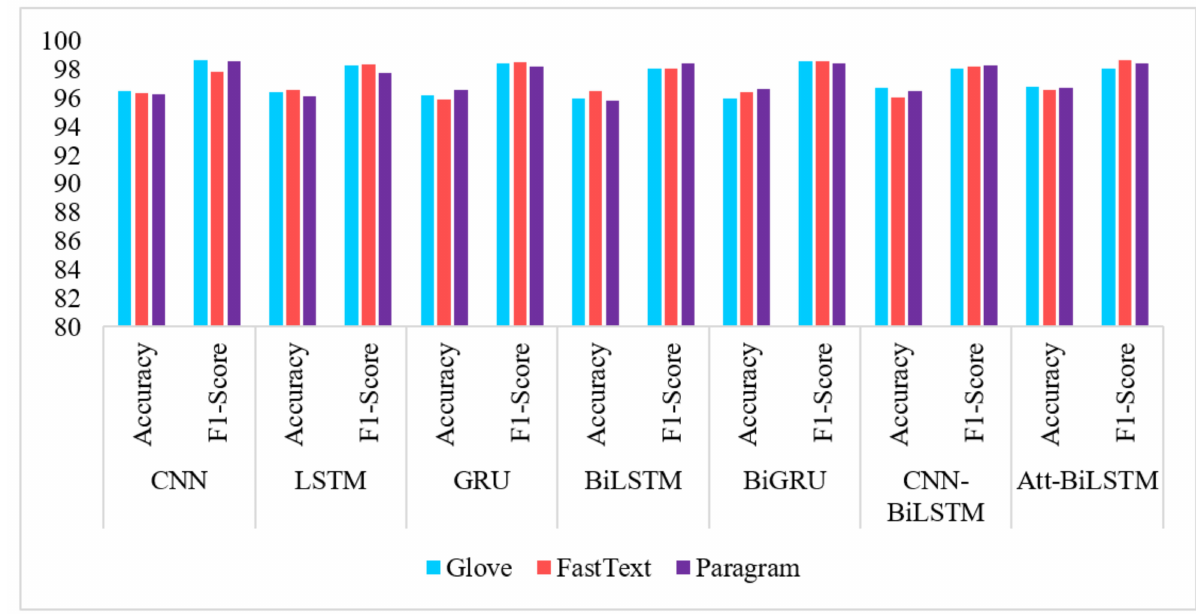
Figure 11. Performance comparison of seven shallow neural networks on Wikipedia Web Toxicity